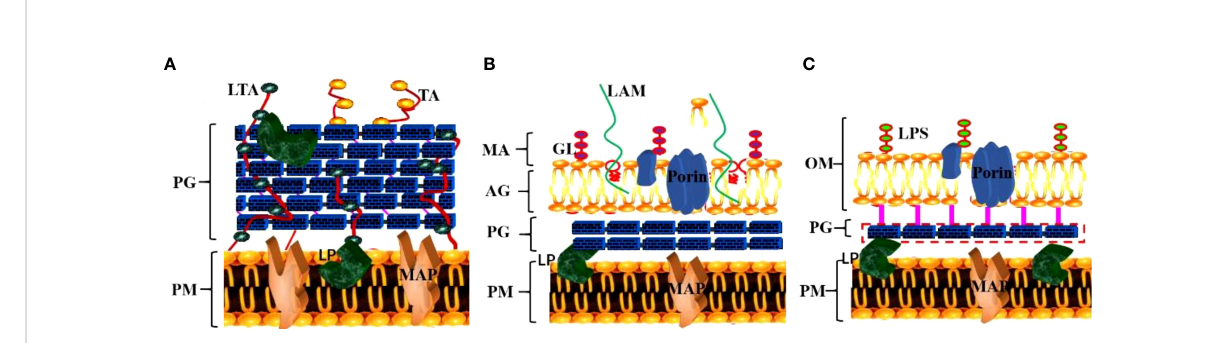
FIGURE 2 Speci fi c structural components of the MTB cell wall. (A) The cell wall structure of gram-positive bacteria; (B) The cell wall structure of MTB; (C) The cell wall structure of gram-negative bacteria. (TA, teichoic acid; LTA, lipoteichoic acid; PG, peptidoglycan; PM, plasma membrane; LP, lipoprotein; MAP, membrane-associated protein; GL, glycolipid; LAM, lipoarabinomannan; MA, mycolic acid; AG, arabinogalactan; LPS, lipopolysaccharide; OM, outer